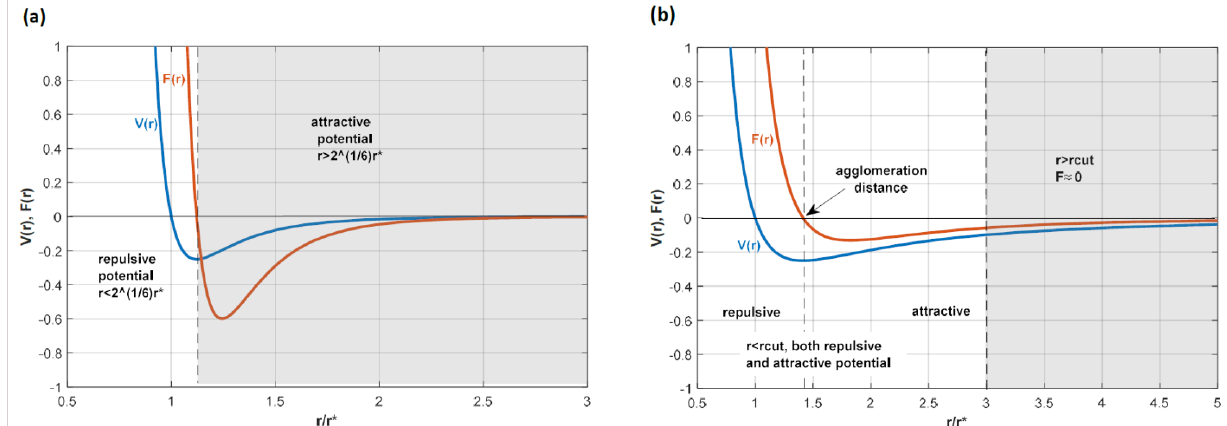
Figure 1. Diagram illustrating ( a ) the 12-6 potential used for the no-penetration conditions and ( b ) the 4-2 potential used for particle agglomeration. In both cases, the cut-off is selected so that only the white area of the diagram is used in the potential. This implies that ( a ) is only repulsive because only the positive part is considered, while in ( b ) the negative part of the force, which is attractive, is considered; particles tend to agglomerate at the location where the force is zero, which is where is the minimum of the potential is